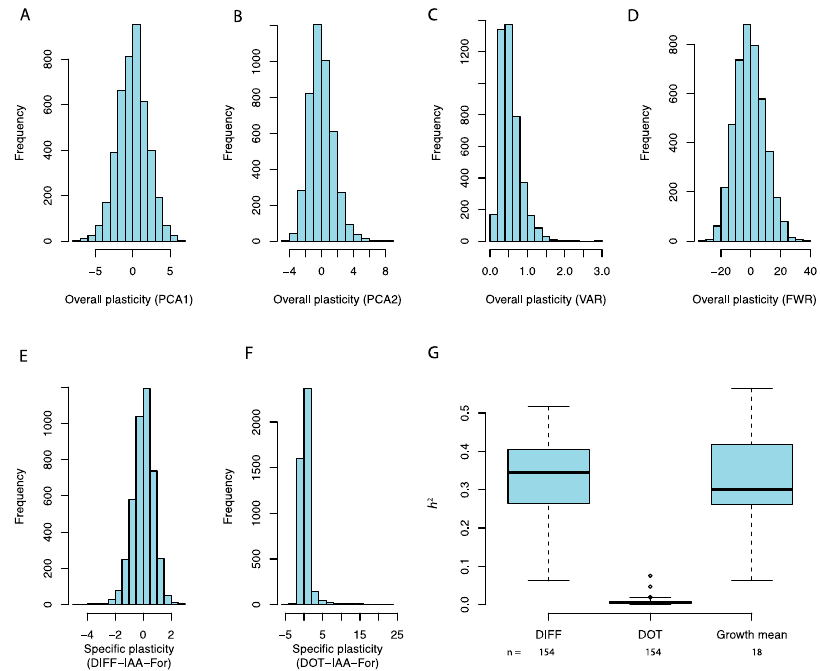
Figure 2. Distributions and narrow sense heritabilities of the evaluated plasticity